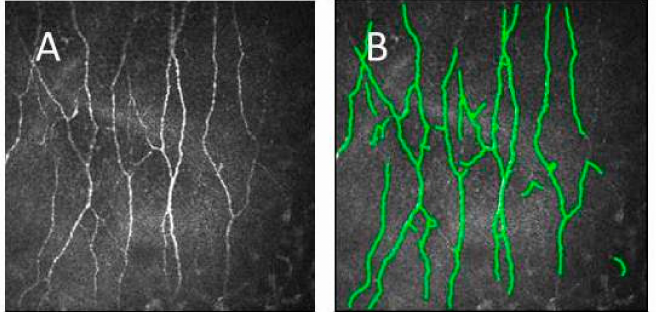
Figure 1. Single image from the subbasal nerve plexus (SNP) in an individual ( A ) and automatically detected nerve fibers used for quantification ( B